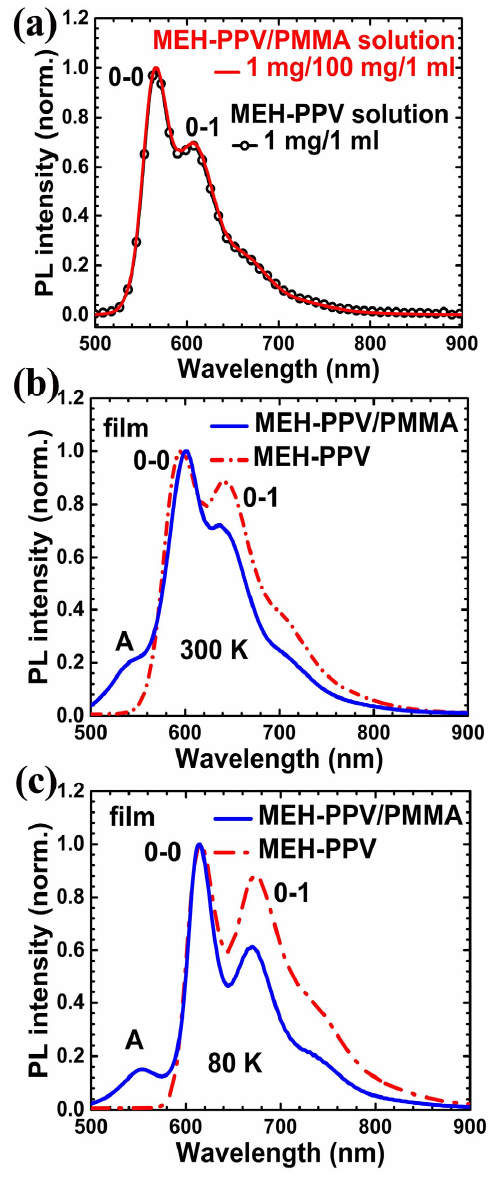
Figure 1. Photoluminescence spectra of MEH-PPV/PMMA and MEH-PPV. ( a ) Chlorobenzene solution measured at room temperature; ( b ) and ( c ) MEH-PPV/PMMA (1:100) and MEH-PPV films measured at 300 and 80 K, respectively.